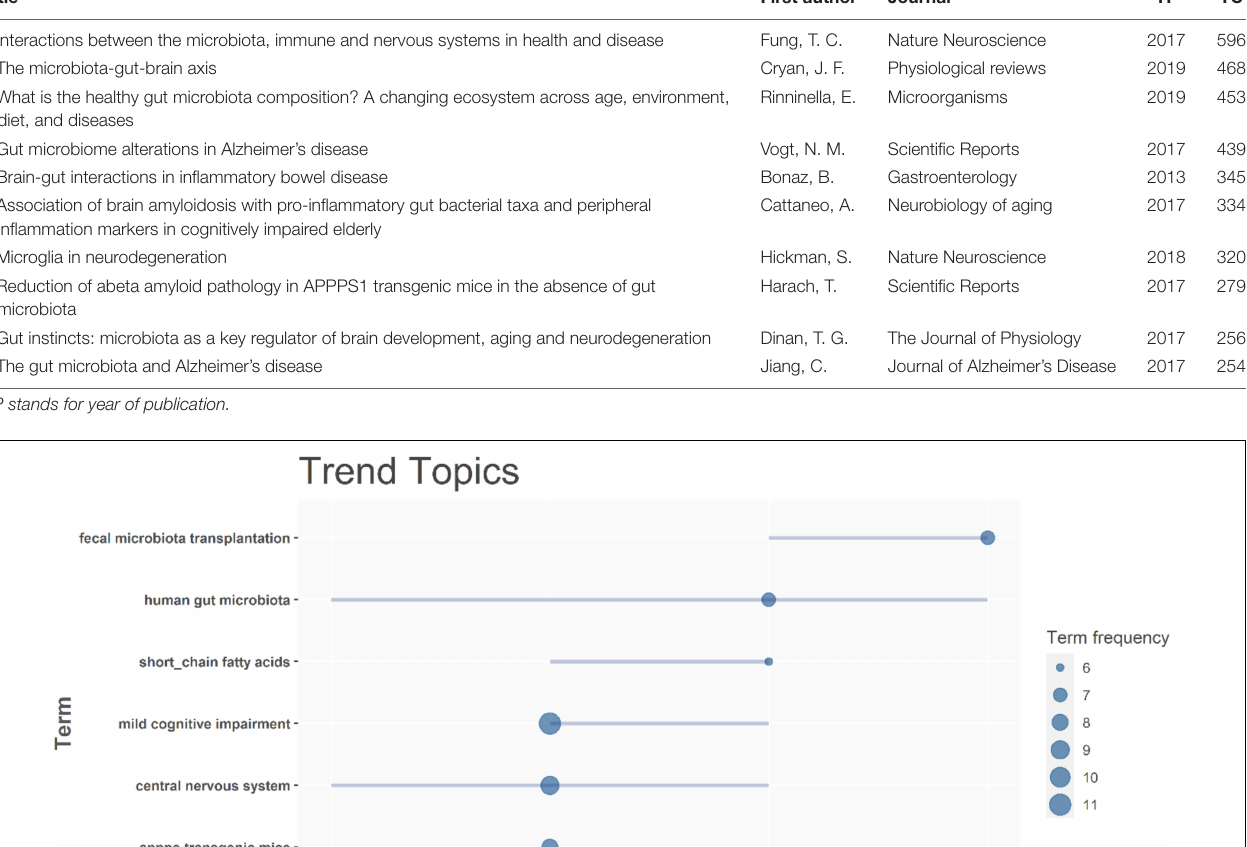
Here, the proximity between words is because a large proportion of articles use them together, and the origin of the map represents the average position of all column profiles and therefore represents the center of the research field (Cuccurullo et al.,